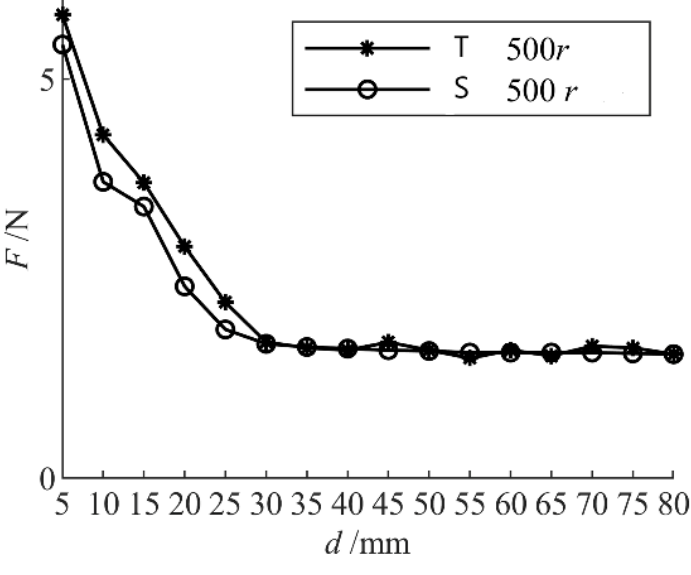
Figure 24. F- d ( v = 500 r/min, δ = 0.2).